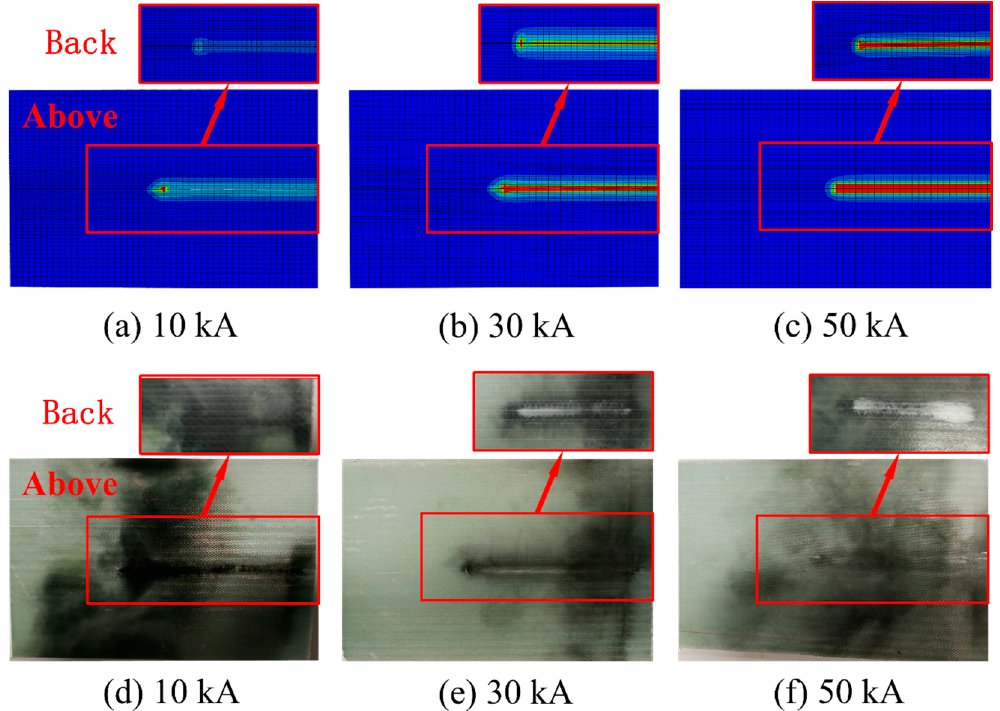
Figure 17. Comparison of lightning strike experiment and simulation damage of GFRC laminate under different peak values.